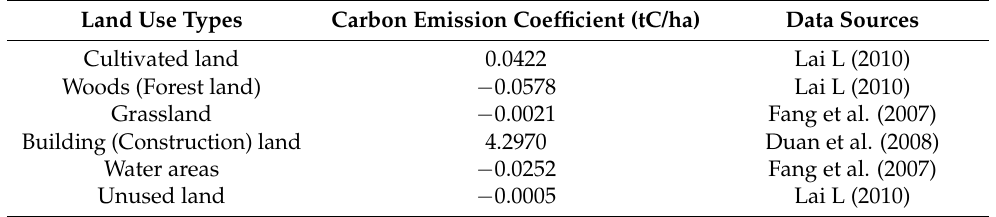
Table 1. Carbon emission coefficient of each land use